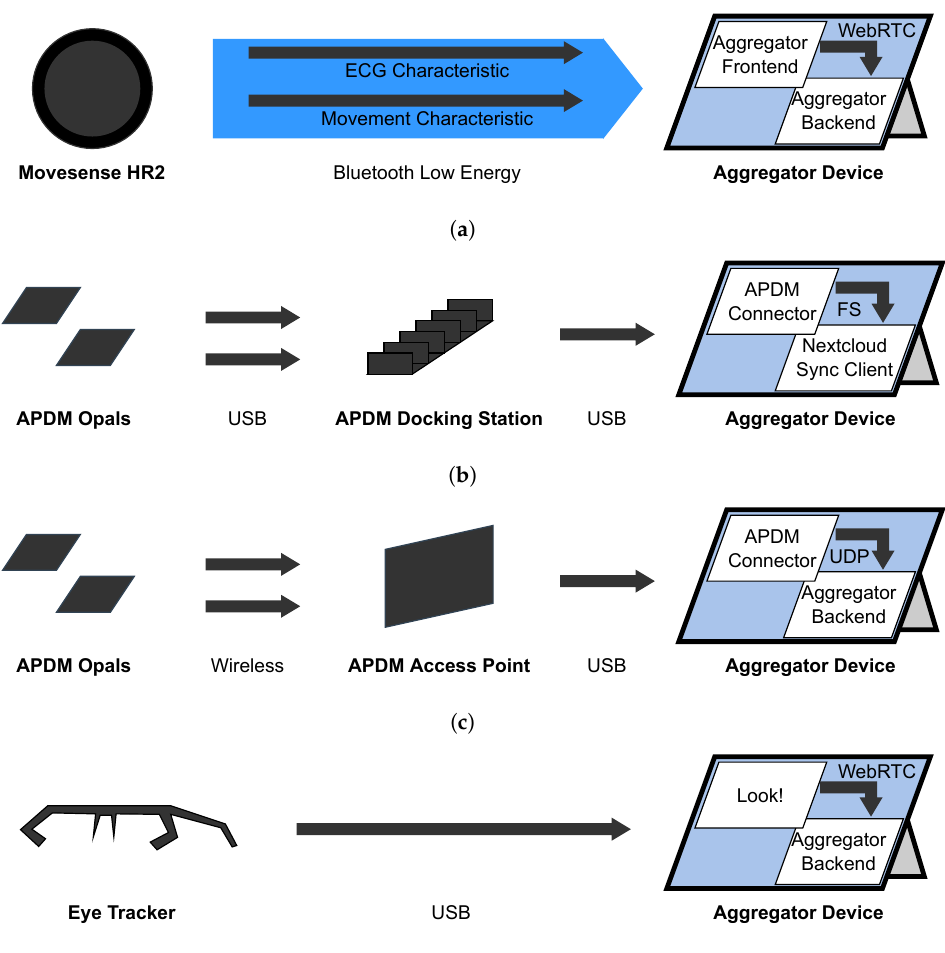
Figure 8. Overview of sensor Streaming and Recording Pipelines. ( a ) Movesense movement and ECG Streaming and Recording Pipeline. ( b ) APDM sensor Recording Pipeline. ( c ) APDM sensor Streaming Pipeline. ( d ) Eye Tracking Streaming and Recording